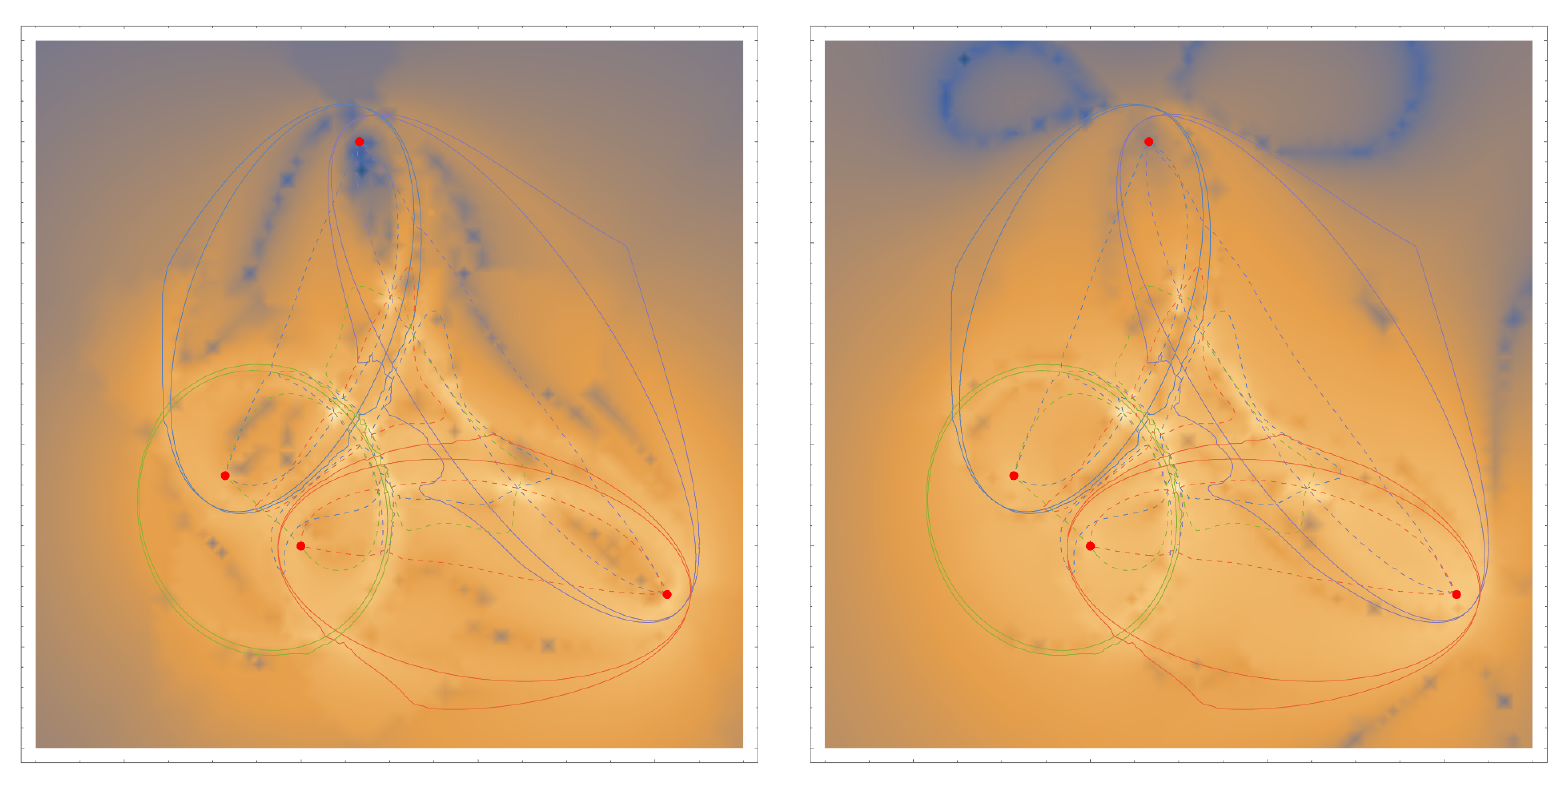
Figure 14. A density plot of the real (left) and imaginary (right) values of the integrand overlaying the undeformed E-surfaces (cid:17) (ellipses) and their solutions to Re (cid:17) = 0 (solid) and Im (cid:17) = 0 (dashed) with deformation. The real and imaginary part of the integrand has pronounced enhancements (white), where the imaginary parts of multiple E-surface equations are zero. The features for vanishing real and imaginary part of the integrand (blue), have no special